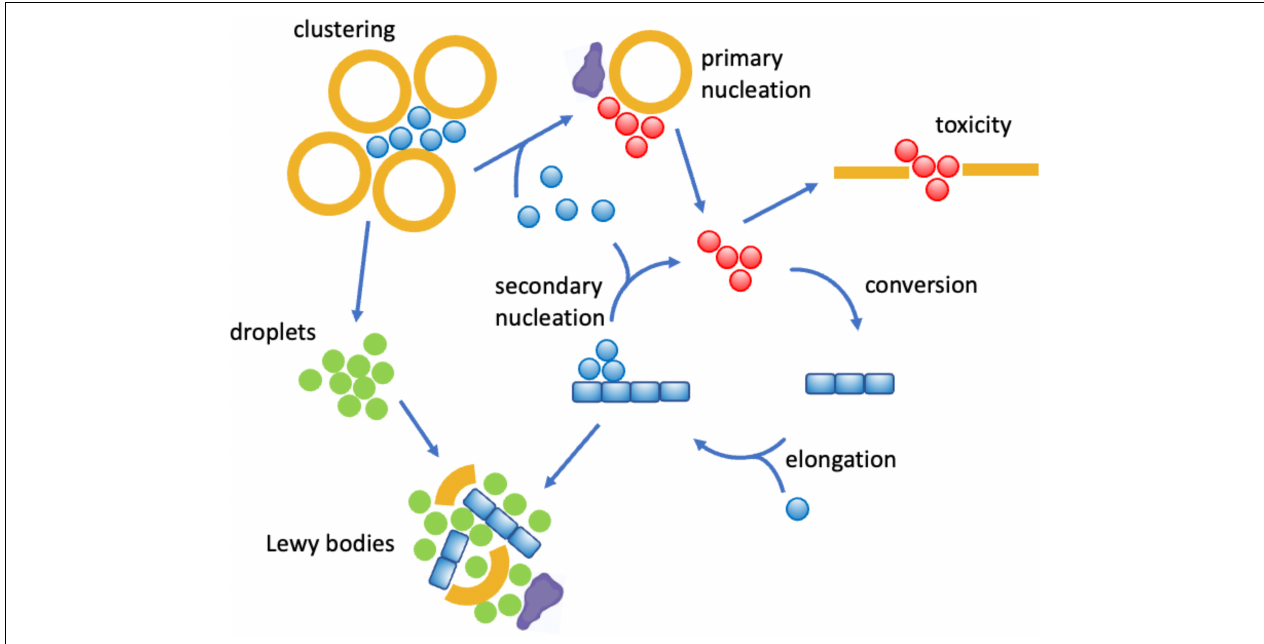
FIGURE 4 | Mechanisms by which lipid dysregulation can affect α -synuclein aggregation in Parkinson’s disease. One of the proposed physiological functions of α -synuclein (blue) is to bind reversibly synaptic vesicles (orange) and to promote their clustering (Murphy et al., 2000; Fusco et al., 2016). However, when multiple α -synuclein molecules bind synaptic vesicles or other lipid assemblies of altered compositions, including exosomes (Danzer et al., 2012; Grey et al., 2015) and lipid droplets (Cole et al., 2002; Soste et al., 2019), they can self-assemble into disordered oligomers (red), which can be cytotoxic by disrupting lipid membranes (Danzer et al., 2007; Fusco et al., 2017), or progress to form amyloid fibrils and Lewy bodies. All these steps can be promoted by lipid membranes of specific compositions (Buell et al., 2014; Galvagnion et al., 2015, 2016) and regulated by interactions with molecular chaperones (purple). The clustering of synaptic vesicles can also open up the condensation pathway by concentrating α -synuclein molecules (Ray et al., 2020; Hardenberg et al., 2021), which may end up in the formation of Lewy bodies through the formation of α -synuclein droplets (Hardenberg et al., 2021)